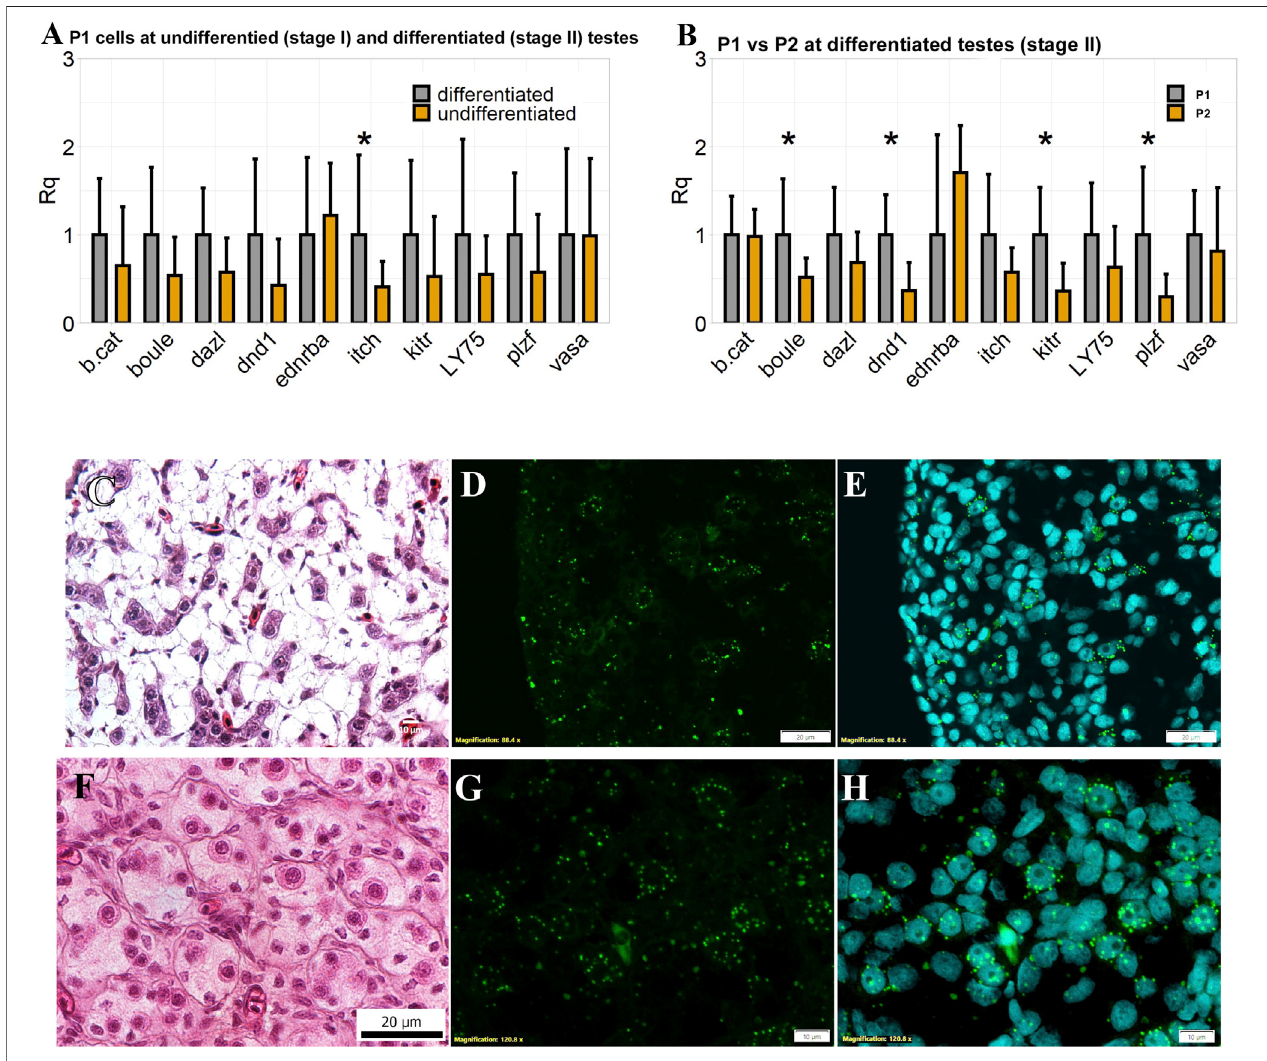
FIGURE 4 | Expression of candidate markers for sorted cell populations. (A) Comparision of germ cell related genes expression pro fi le of P1 cells between stage I andIItestesbyq-PCR.GeneexpressionsinstageIwerede fi nedastherelativevalue1.0. (B) Comparisionofgermcellrelatedgeneexpressionpro fi lesofP1andP2cells at stage II testes by q-PCR. Gene expressions in P1 were de fi ned as the relative value 1.0. Cq values were normalized per gene for relative quanti fi cation using the arithmetic meanof differentiated group values (A) and P1values (B) . Rq (cid:1) 2 −( Cq − x 3 ) . Data arepresented asgeometric mean value ± geometric standard deviation (GSD).Meanswithanasteriskindicateasigni fi cantdifference(n (cid:1) 3, p < 0.05). (C) Histologicalobservationofearlystagetestesusedfor insitu hybridization(ISH). (D) The cellular distributions of plzf by ISH. (E) Merged photograph with DAPI. (F) Histological observation of testes at a later maturing stage used for ISH. (G) The cellular distributions of plzf by ISH. (H) Merged photograph with